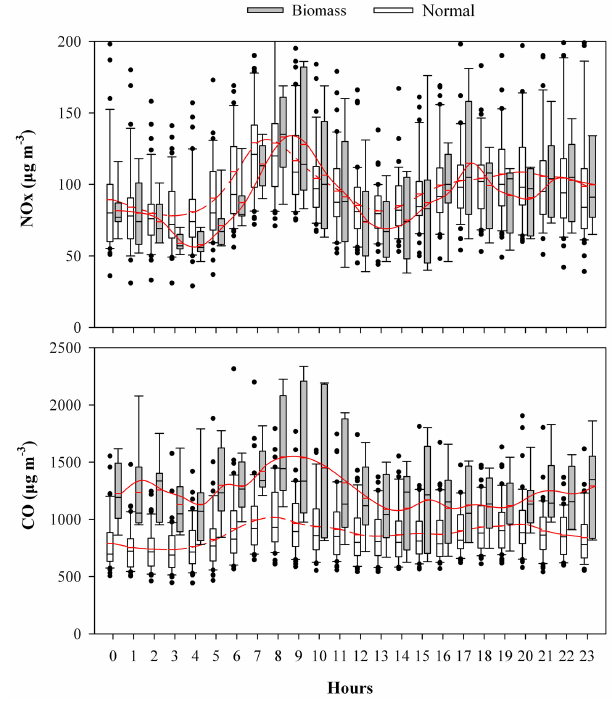
Fig. 11. The diurnal variation of CO and NOx concentrations ( μ gm -3 ) during the biomass burning period (gray box) and normal period (white box), respectively. Diurnal mean values are connected by the red spline curves; bottom and top of the boxes represent the 25 and 75% limits, respectively; and bottom and top short lines represent the minimum and maxium values, respectively; Black dots represent the outliers.